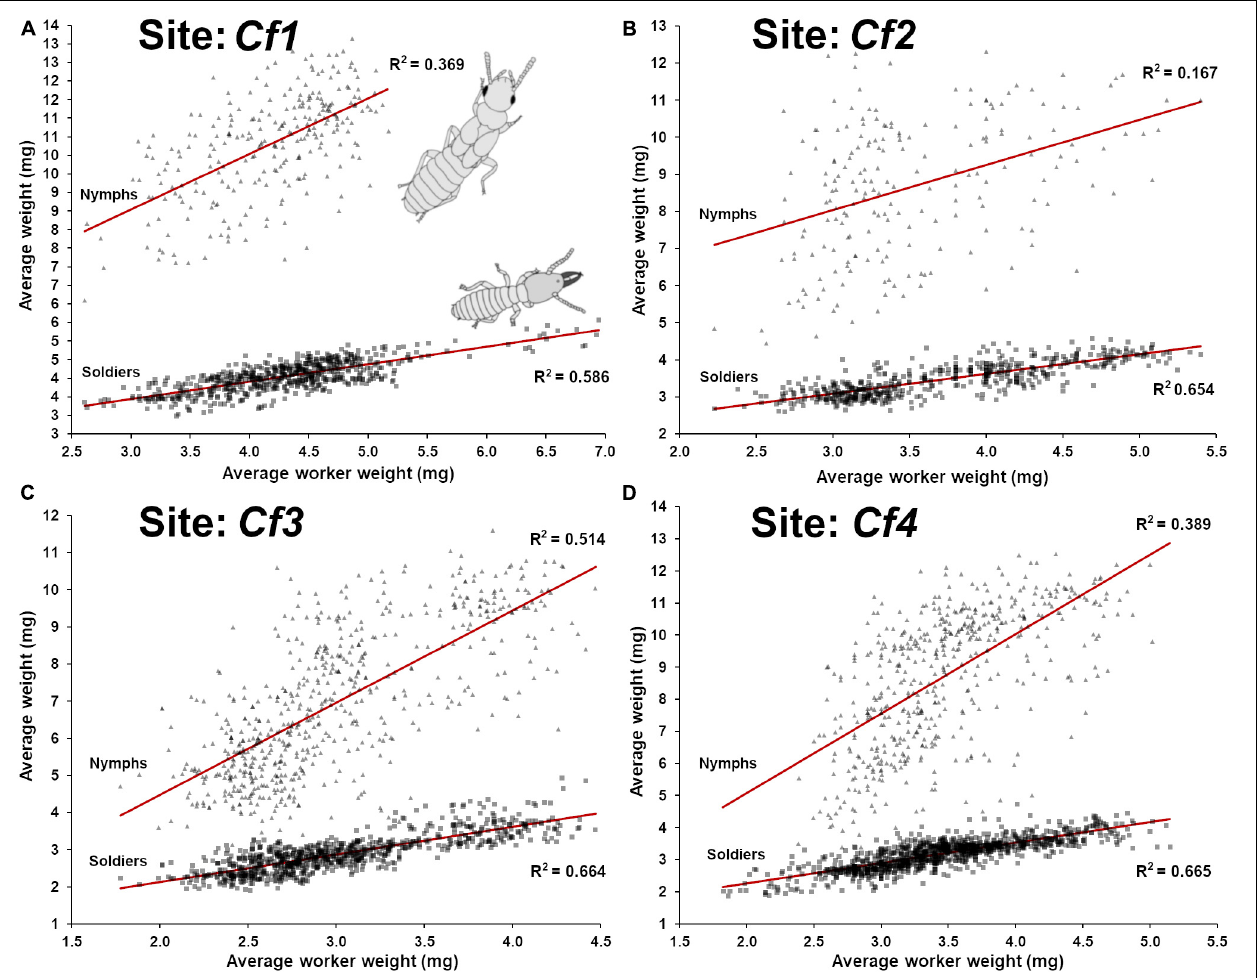
FIGURE 3 | Relationship between the average weight of workers and the average weight of soldiers and nymphs in field traps throughout the time of a site observation. (A) Site Cf1 (1988–1997), worker-soldier ( lm , F 1 , 620 = 879.0, p < 0.001, R 2 = 0.586) and worker-nymph ( lm , F 1 , 258 = 151.1, p < 0.001, R 2 = 0.369) relationships. (B) Site Cf2 (1986–1996), worker-soldier ( lm , F 1 , 523 = 989.6, p < 0.001, R 2 = 0.654) and worker-nymph ( lm , F 1 , 197 = 38.6, p < 0.001, R 2 = 0.167) relationships. (C) Site Cf3 (1988–2009), worker-soldier ( lm , F 1 , 852 = 1,687, p < 0.001, R 2 = 0.664) and worker-nymph ( lm , F 1 , 611 = 646.7, p < 0.001, R 2 = 0.514) relationships. (D) Site Cf4 (1986–2009), worker-soldier ( lm , F 1 , 1064 = 2,116, p < 0.001, R 2 = 0.665) and worker-nymph ( lm , F 1 , 508 = 323.2, p < 0.001, R 2 = 0.389)